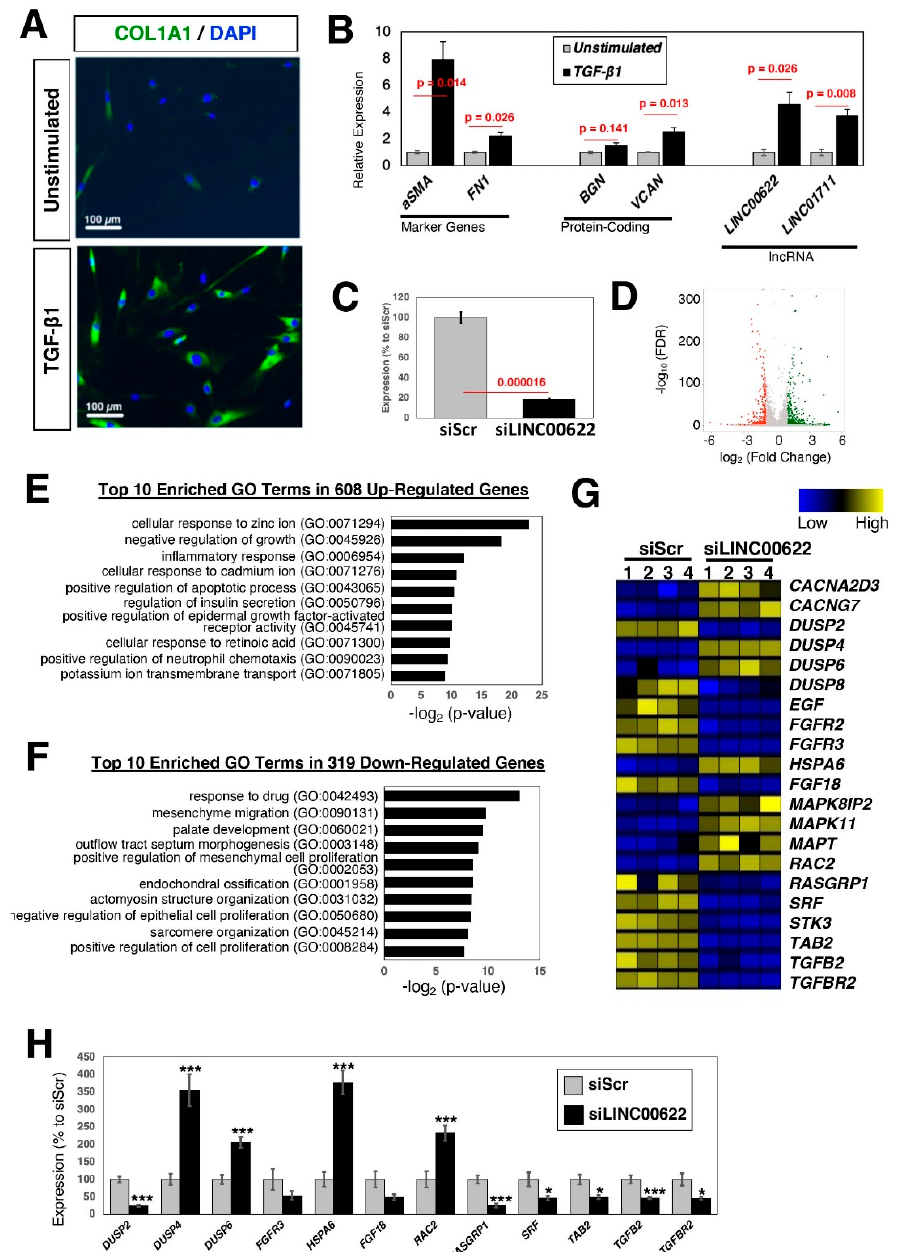
Figure 5. Loss-of-function experiments of the candidate lncRNA, LINC00622 , in dermal fibroblasts. ( A ) Protein expression of myofibroblast marker, COL1A1. Fibroblasts were stimulated with TGF- β 1 (5 ng/mL) for 24 h. The nuclei were counterstained with DAPI. Representative images are shown from more than 3 independent experiments. ( B ) qRT-PCR results of fibrotic marker genes, up-regulated protein-coding, and lncRNA genes. For AL121749.2 , it is not expressed in both unstimulated and TGF- β 1-stimulated dermal fibroblasts. n = 4 biological replicates per condition. ( C ) qRT-PCR results upon silencing of LINC00622 . Twenty-four hours after addition of siRNA to the growth medium, the cells were serum starved for one day and stimulated with TGF- β 1 for 24 h in the presence of siRNAs. n = 6 biological replicates per condition. ( D ) Volcano plot of RNA-seq data. There are 608 up- and 319 down-regulated genes when the threshold values of 2-fold and FDR-adjusted p -values <0.05 were applied. n = 4 biological replicates per condition. ( E , F ) Top 10 enriched GO terms for ( E ) up- and ( F ) down-regulated genes. ( G ) Heatmap of differentially expressed genes categorized under the KEGG pathway for MAPK. ( H ) qRT-PCR results of differentially expressed genes. n = 6 biological replicates per condition. * ( p < 0.05) and *** ( p <